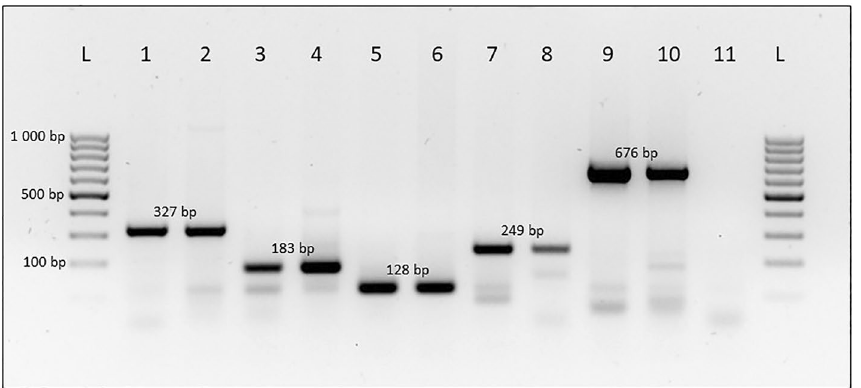
Figure 3. 2% agarose-TAE gel displaying the efficacy of the Multiplex PCR assay to identify wild, trap-collected specimens with examples of non-specific amplification. Species-specific amplicon sizes are indicated. Lanes 1 & 2: C. capitata , Lanes 3 & 4: C. cosyra , Lanes 5 & 6: C. quilicii , Lanes 7 & 8: C. rosa , Lanes 9 & 10: B. dorsalis , Lane 11: No template control, Lane L: GeneRuler 100 bp DNA ladder (Thermo Scientific). The original gel is presented in Supplementary Fig.